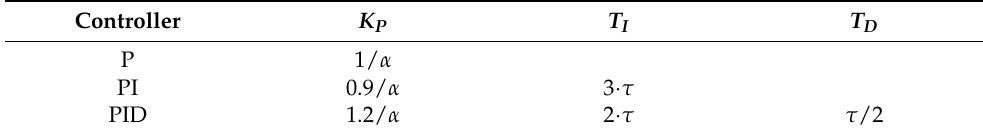
Table 2. PID control parameters tuning (Ziegler-Nichols step response method) [37].